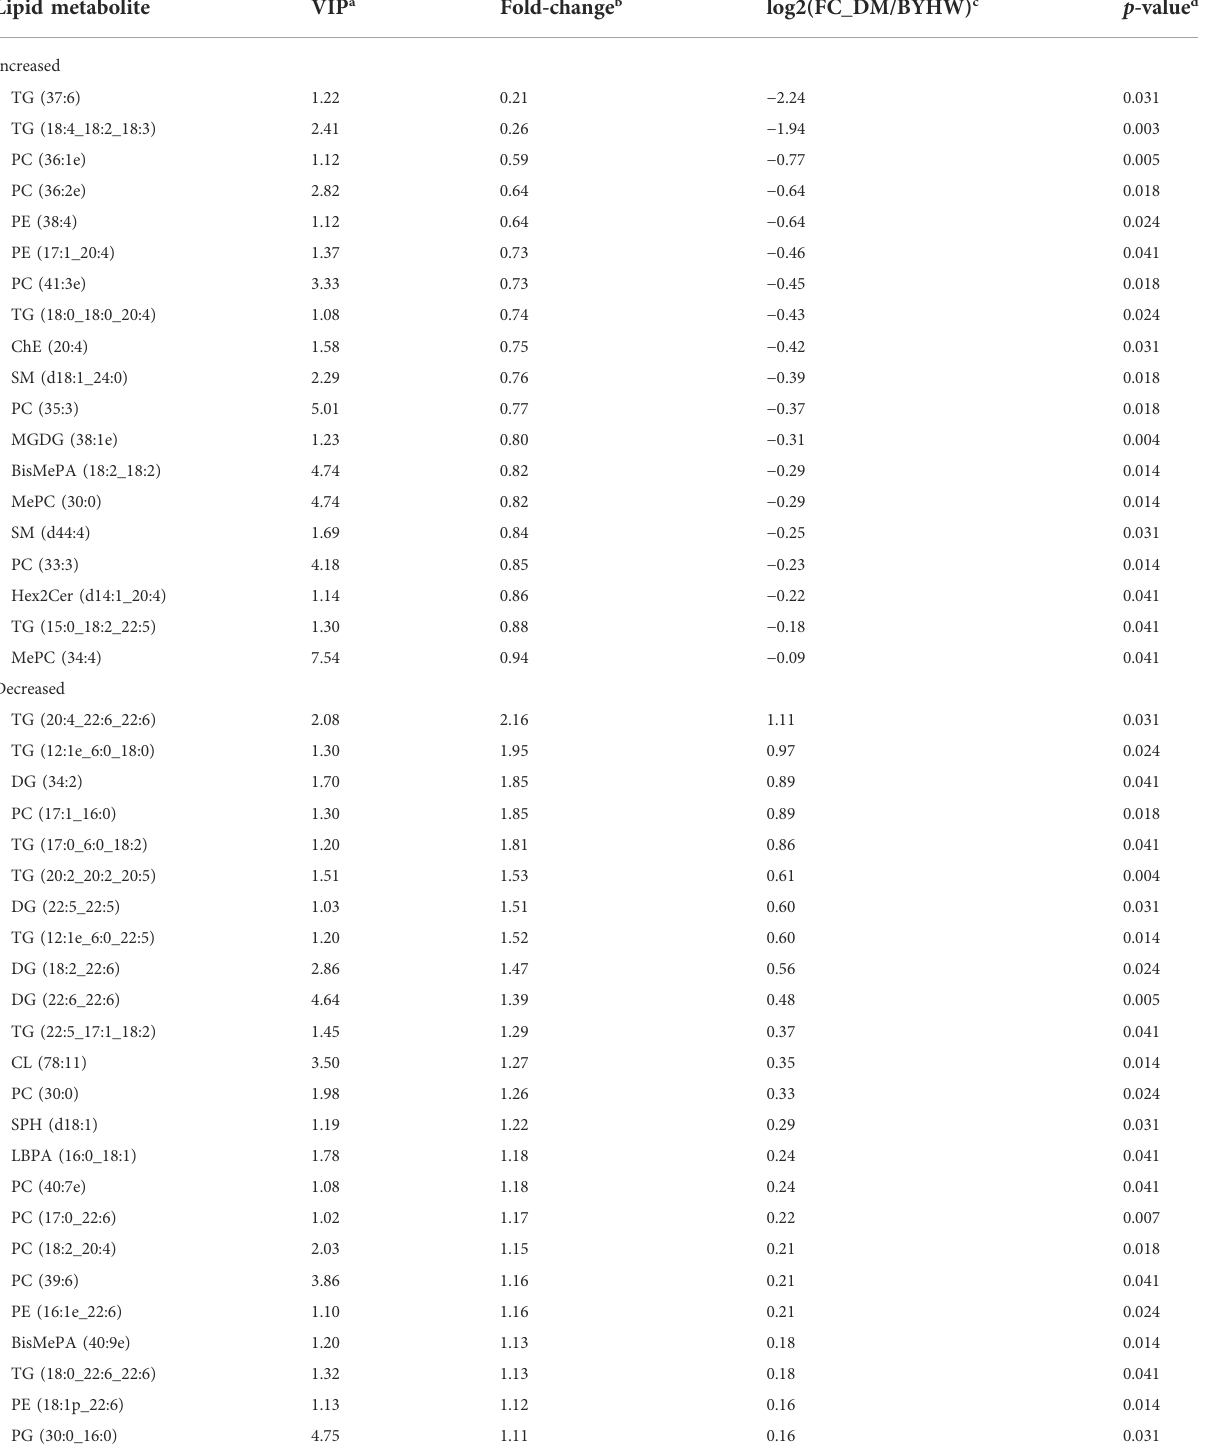
TABLE 1 Signi fi cantly different qualitative lipid metabolites in the liver samples from ZDF rats after BYHWD treatment. Lipid metabolite VIP a Fold-change b log2(FC_DM/BYHW) c p -value